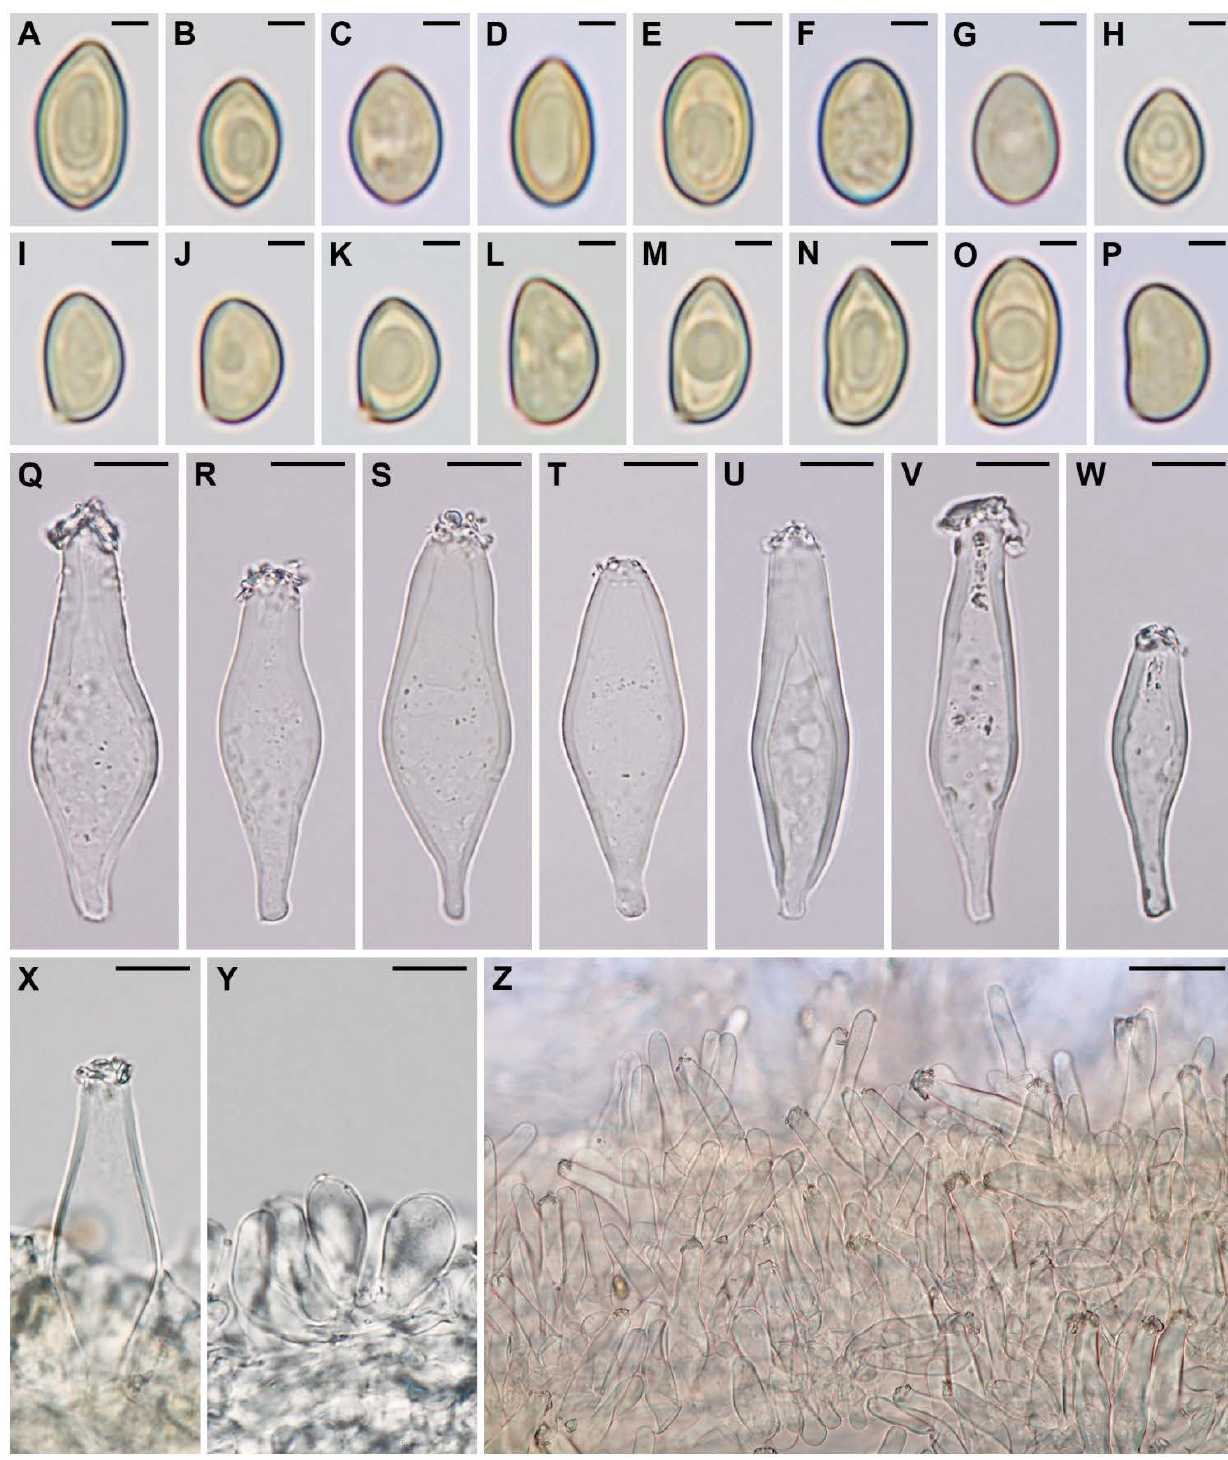
Figure 3. Inocybe brijunica (CNF 1/7345, holotype). ( A – H ) Basidiospores in frontal view. ( I – P ) Basidiospores in side view. ( Q – W ) Pleurocystidia. ( X ) Cheilolamprocystidium. ( Y ) Cheiloleptocystidia. ( Z ) Caulocystidia. Bars: ( A – P ) = 2 µ m, ( Q – Y ) = 10 µ m, Z = 30 µ